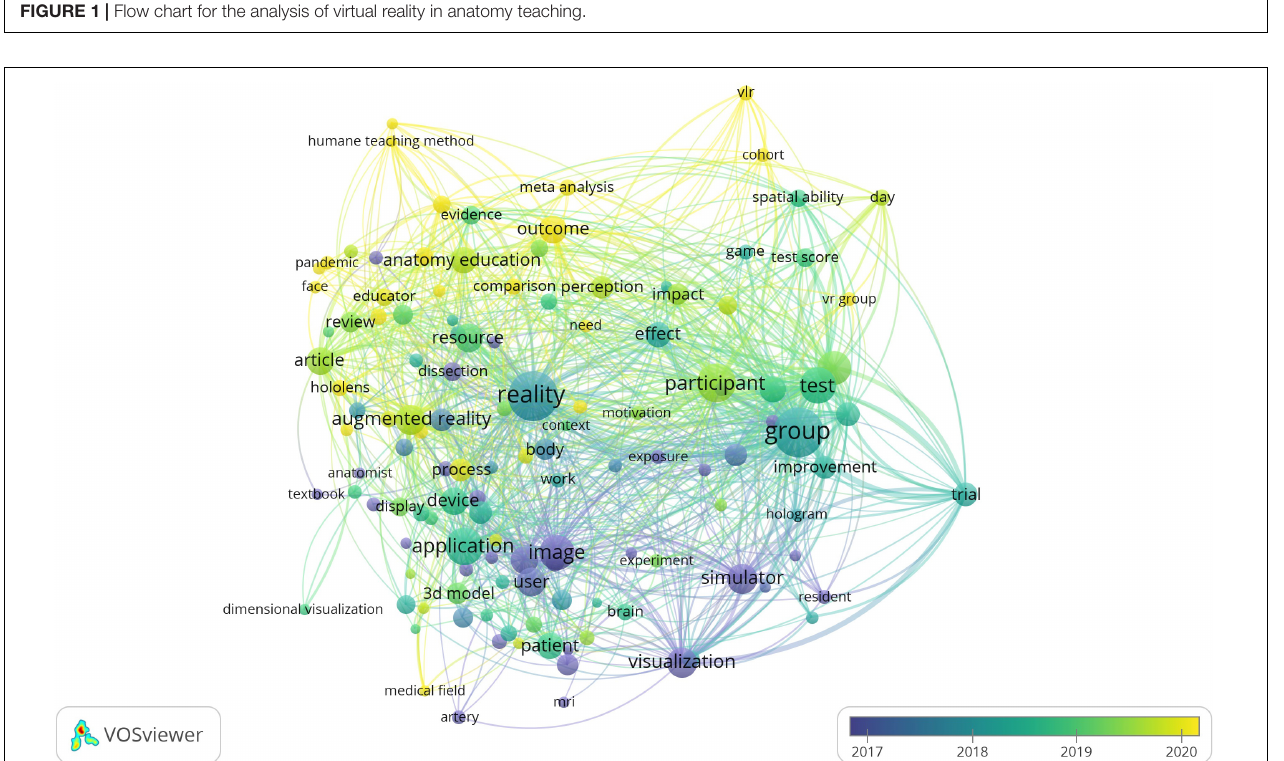
FIGURE 1 | Flow chart for the analysis of virtual reality in anatomy teaching.